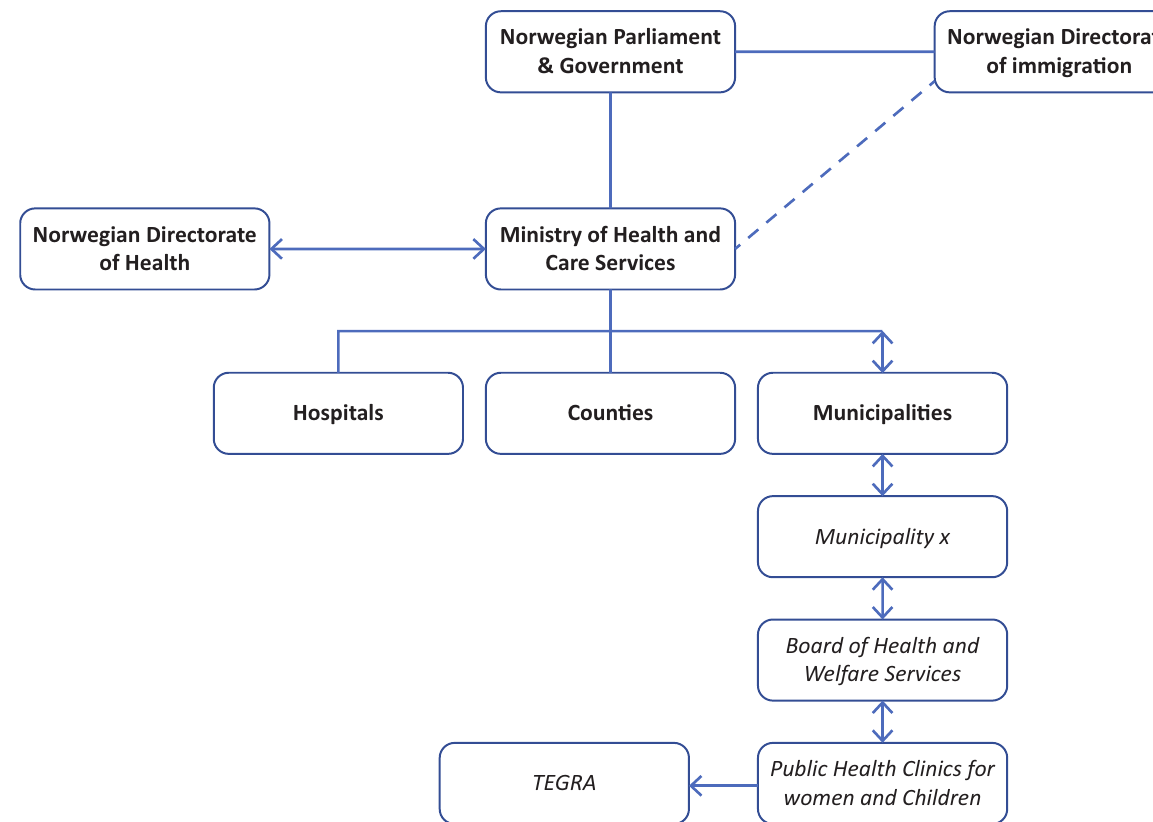
Figure 1. Organization of health services in Norway. Figure adapted from Ringard, Sagan, Saunes, and Lindahl (2013, p. 17, Figure